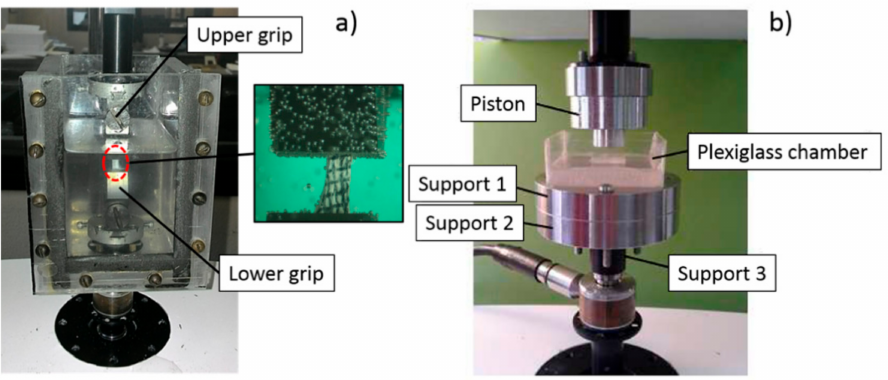
Figure 2. Setup for tension ( a ) and unconfined compression ( b ) tests: ( a ) the sample was clamped between two grips and kept hydrated with a saline solution in a custom-made chamber. A zoom of the sample during the tension test is shown; ( b ) the sample was placed in a Plexiglas chamber filled with a saline solution for hydration and compressed with the